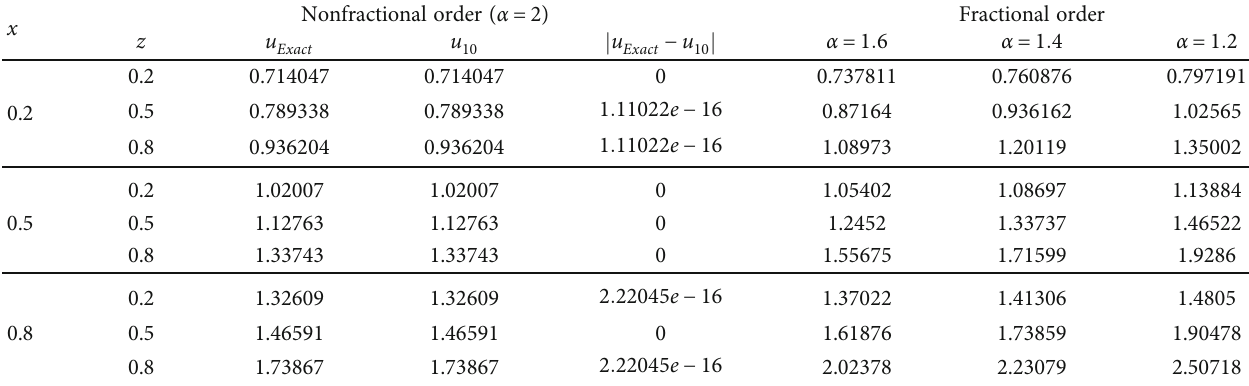
Table 2: Exact solution of nonfractional order and tenth-order approximate solutions of